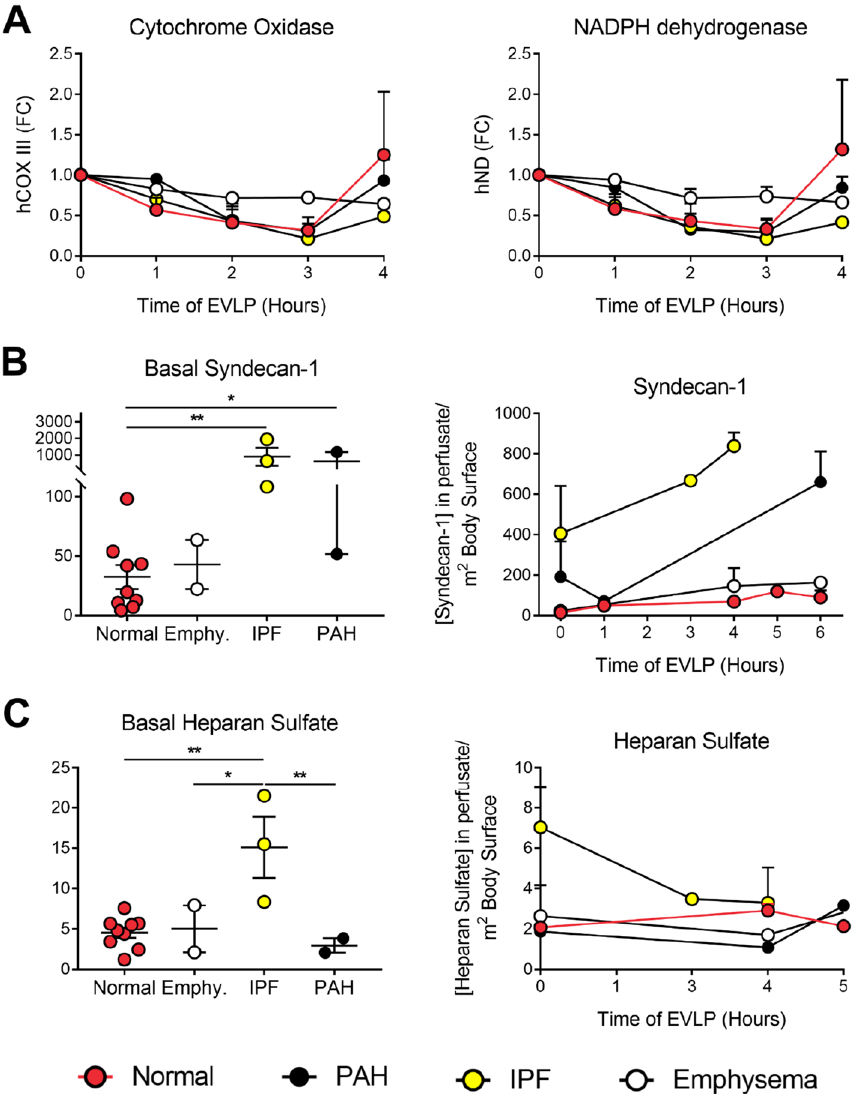
Figure 2. Soluble markers of cellular damage. ( A ) Mitochondrial DNA measured by qPCR of Cytochrome Oxidase and NADPH dehydrogenase, normalized to genomic DNA. The concentration of Syndecans ( B ) and Heparan sulfate ( C ) mRNA analysis of perfusate fluid measured by ELISA shown basal levels before EVLP (left) and through the course of the EVLP (right). *p < 0.05; **p <